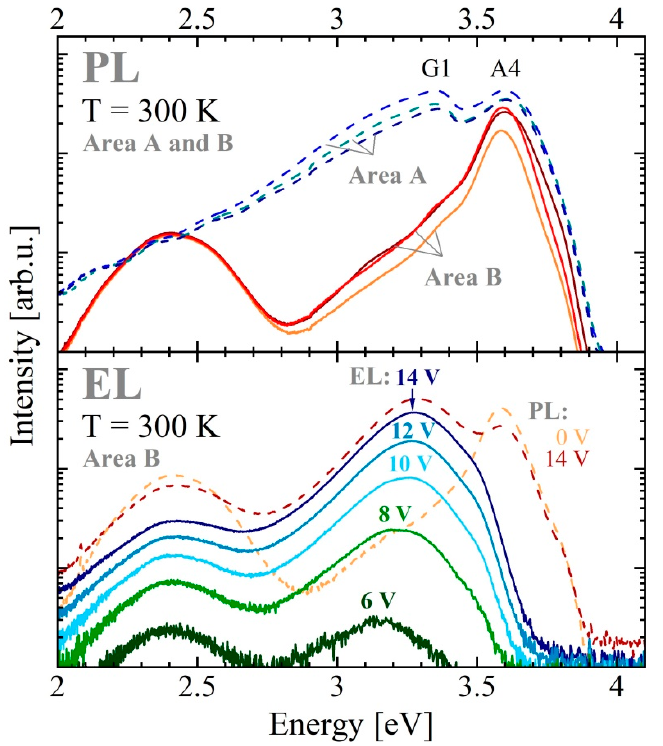
Figure 4. Luminescence spectra at room temperature: PL at different points in the sample (upper panel) and EL at different voltages (bottom panel). It can be observed that the GaN-related G1 peak is much stronger in area A. However, in area B, it was possible to obtain EL, which was dominated by the G1 peak.